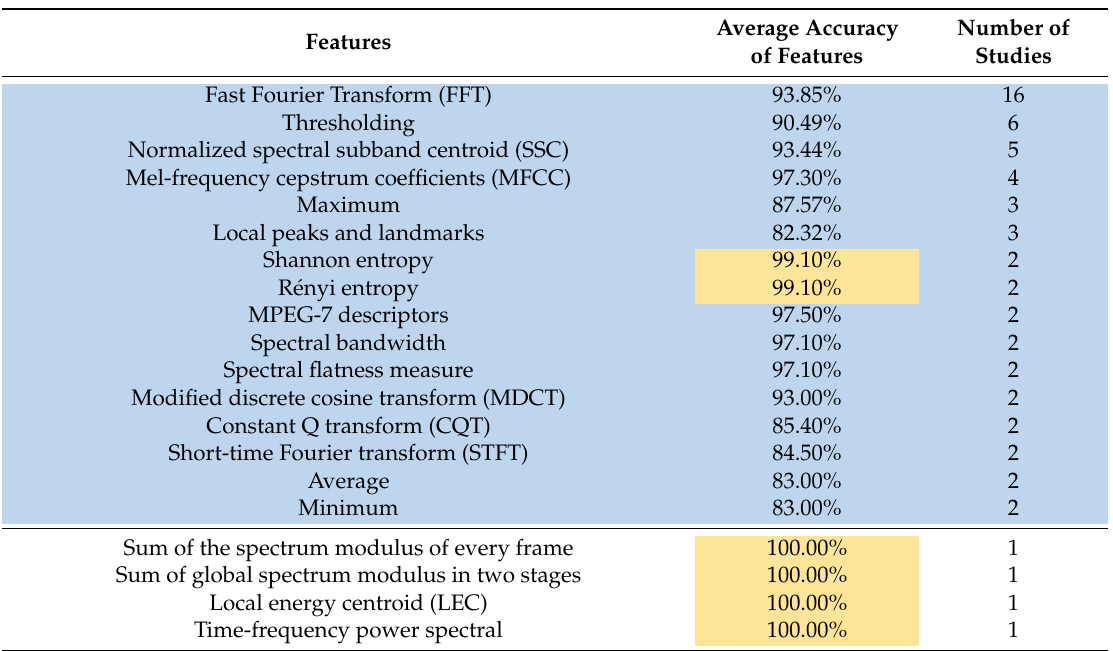
Table 3. Distribution of the features extracted in the